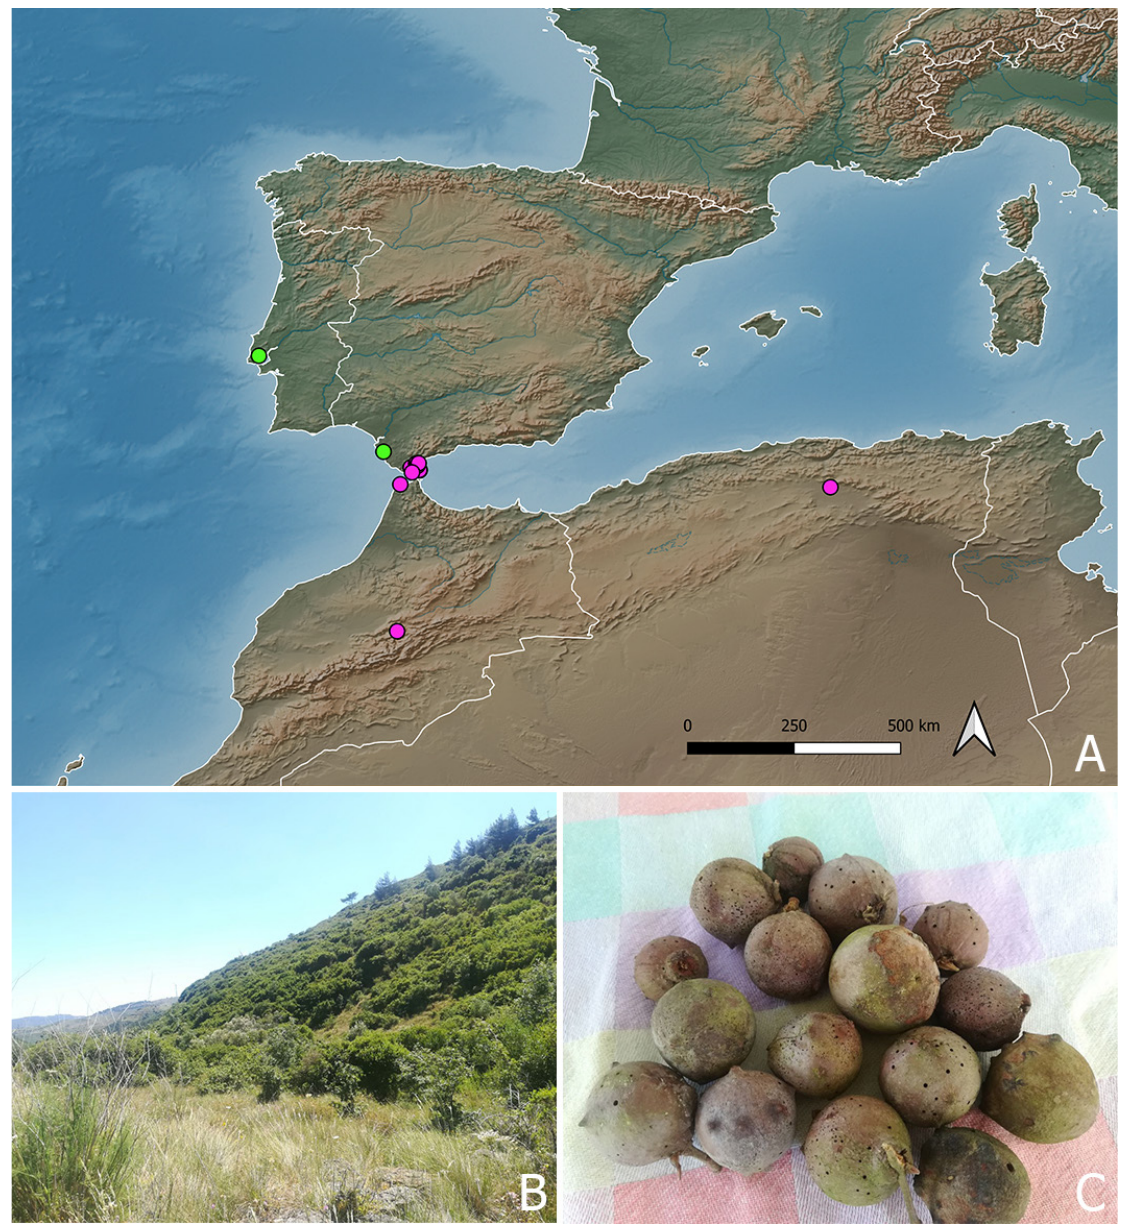
Fig 1 . A: known records of T. convexus (pink circles) and new locations (green circle). B: general view of the habitat where the sample from Lisbon was found. C: galls from the same place where the sample was